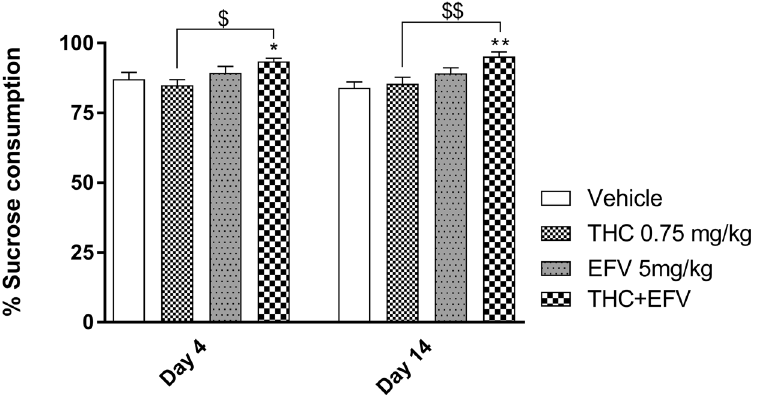
Figure 3. % Sucrose consumption in the sub-chronic drug exposure groups on day 4 and 14 of drug exposure. Tetrahydrocannabinol (THC); Efavirenz (EFV); Methamphetamine (MA). * p < 0.05, ** p < 0.01 vs. Vehicle;